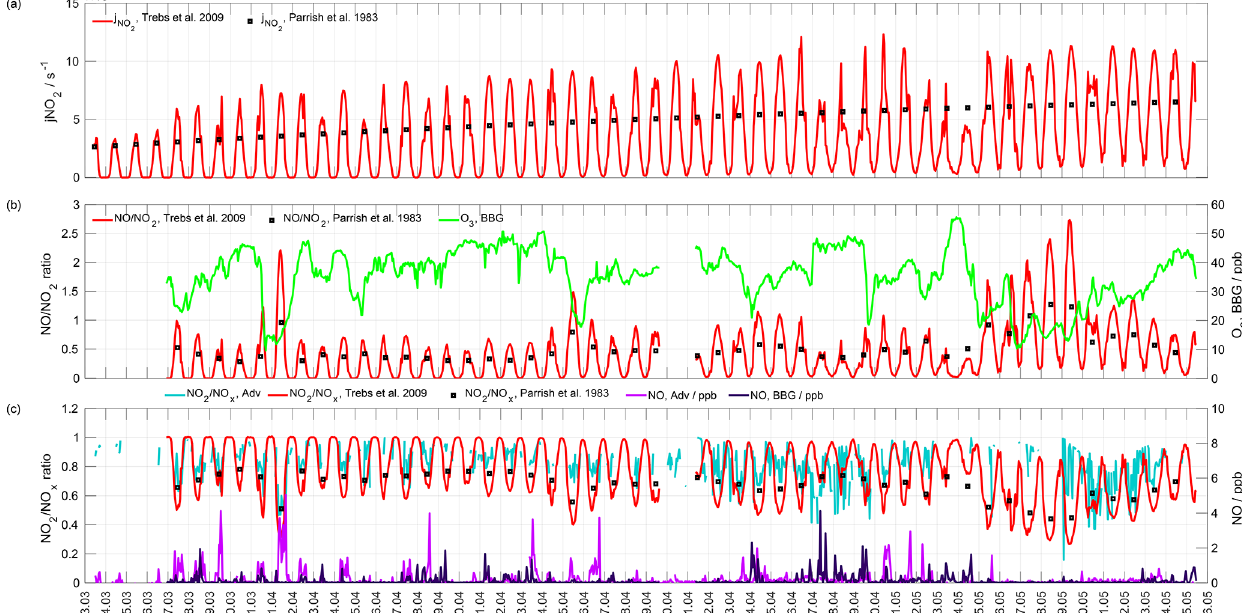
calculated as a function of solar zenith angle in clear-sky conditions (Parrish et al., 1983) (decreasing from 77 to 59 ◦ for Figure A1. (a) j NO 2 solar noon time in Adventdalen from 23 March to 15 May 2017 (Robertson et al., 2006)) and as a function of observed global radiation and albedo (Trebs et al., 2009); (b) NO / NO 2 ratio calculated using O 3 concentration measured in Barentsburg, j NO rate coefficient k NO + O obtained using temperatures in Adventdalen (Eq. 6.6 and Table 6.1 in Seinfeld and Pandis, 2006); (c) observed and 3 calculated NO 2 / NO x ratio for Adventdalen.